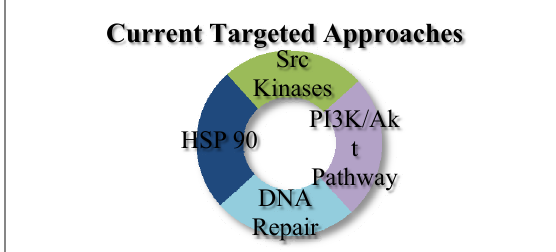
Figure 1. Current therapeutic targets for TNBC treatment.